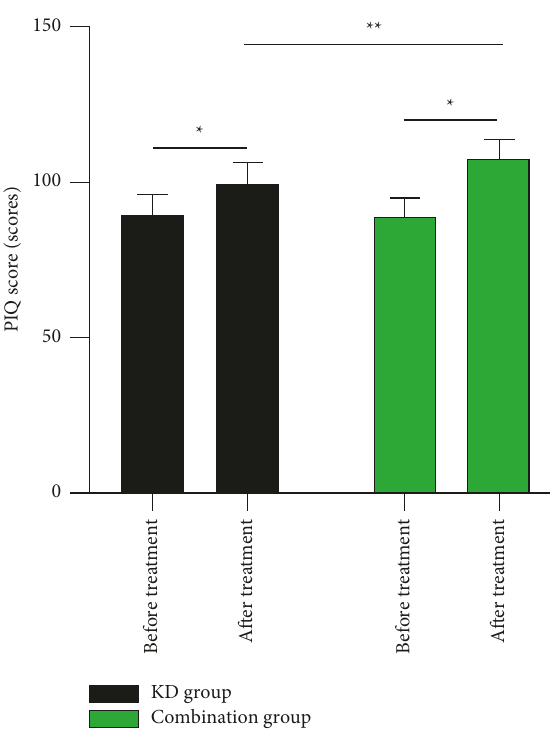
Figure 3: VIQ score between the two groups of children before and after treatment. ∗ Comparison between the same group before and after treatment, P < 0 . 05; ∗∗ comparison between groups after treatment, P < 0 . 05.